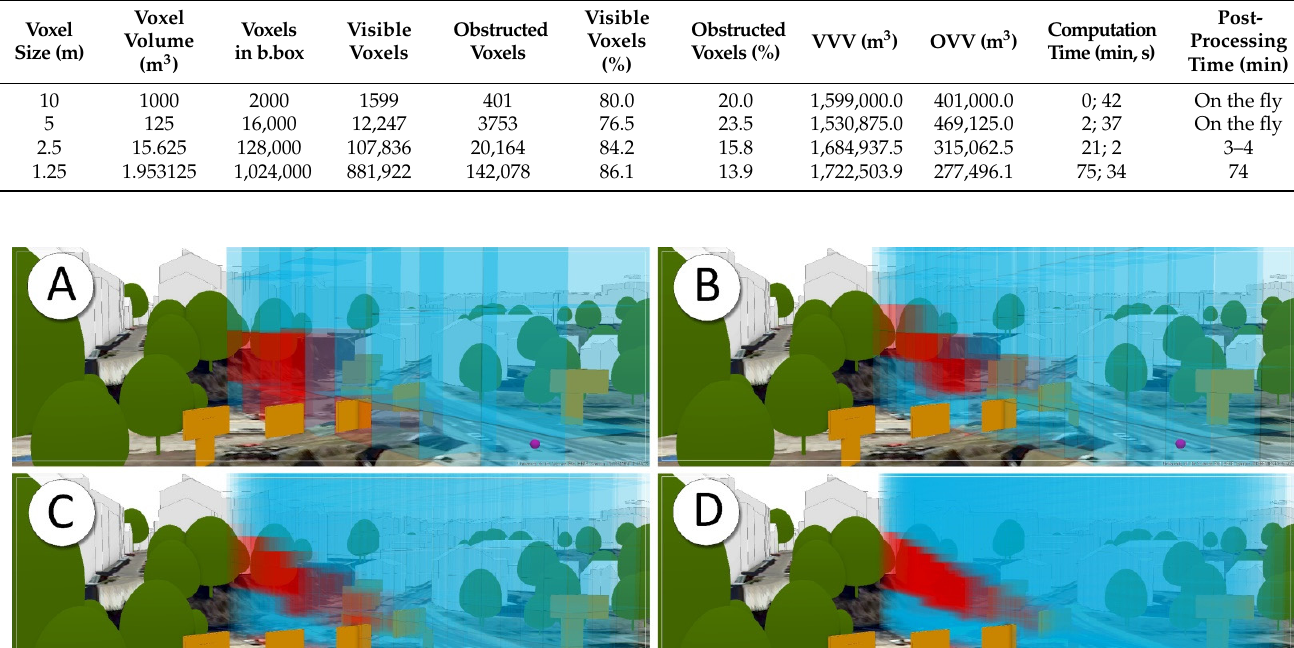
Table 1. The pre-test results on optimal voxel size.